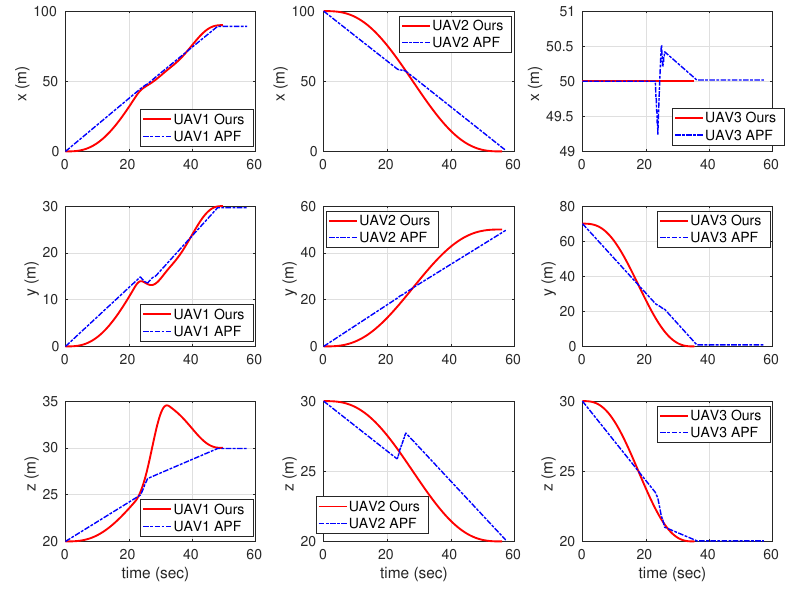
Figure 15. Positions of each UAV in the case of only dynamic